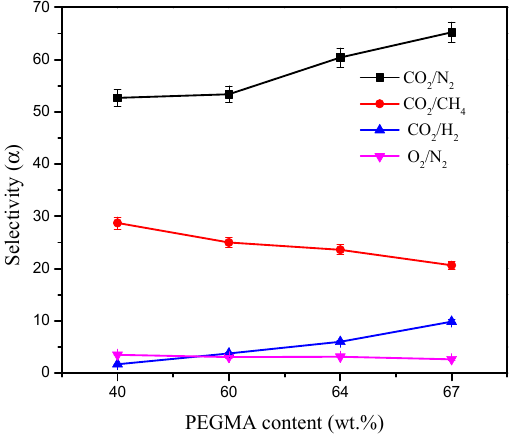
Figure 9. Plot of membrane gas selectivities versus content of PEGMA (wt %).